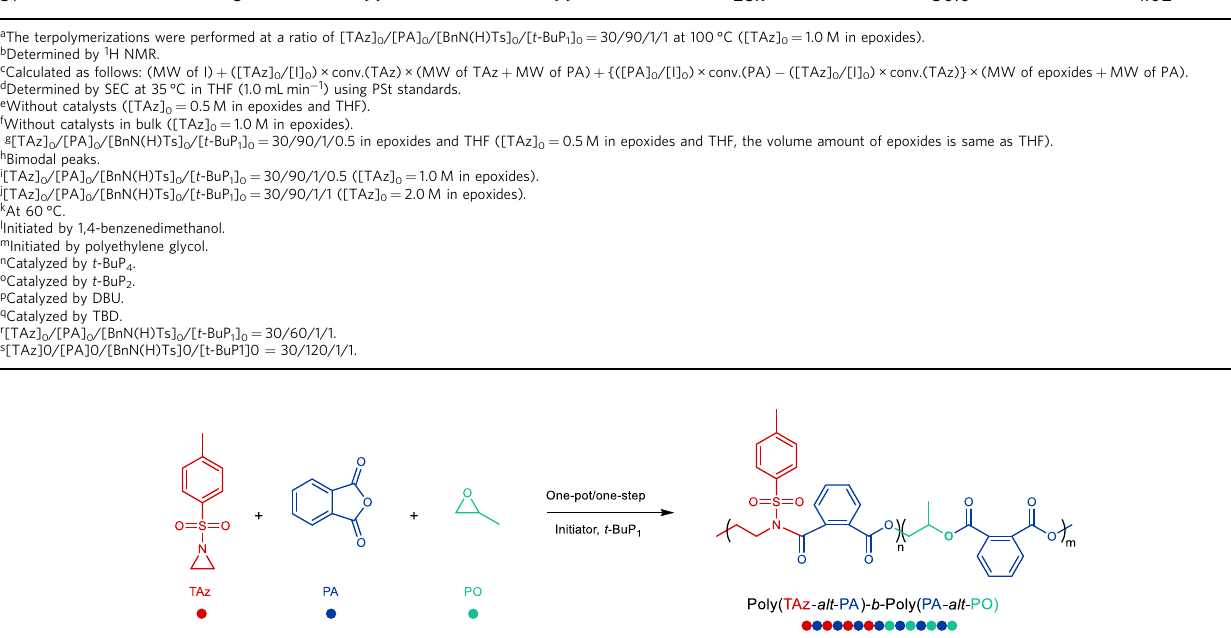
Fig. 1 Terpolymerizations of TAz, PA, and PO. The synthesis of diblock dialternating terpolymers with a sharp boundary instead of a tapered sequence at the conjunction between the two alternating